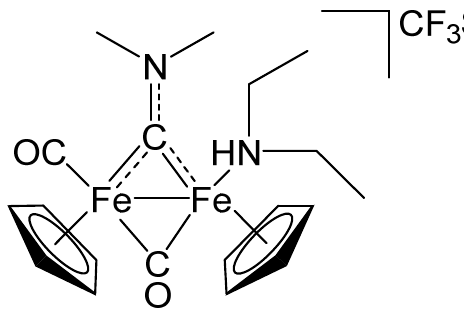
Figure 6. Structure of 4a.